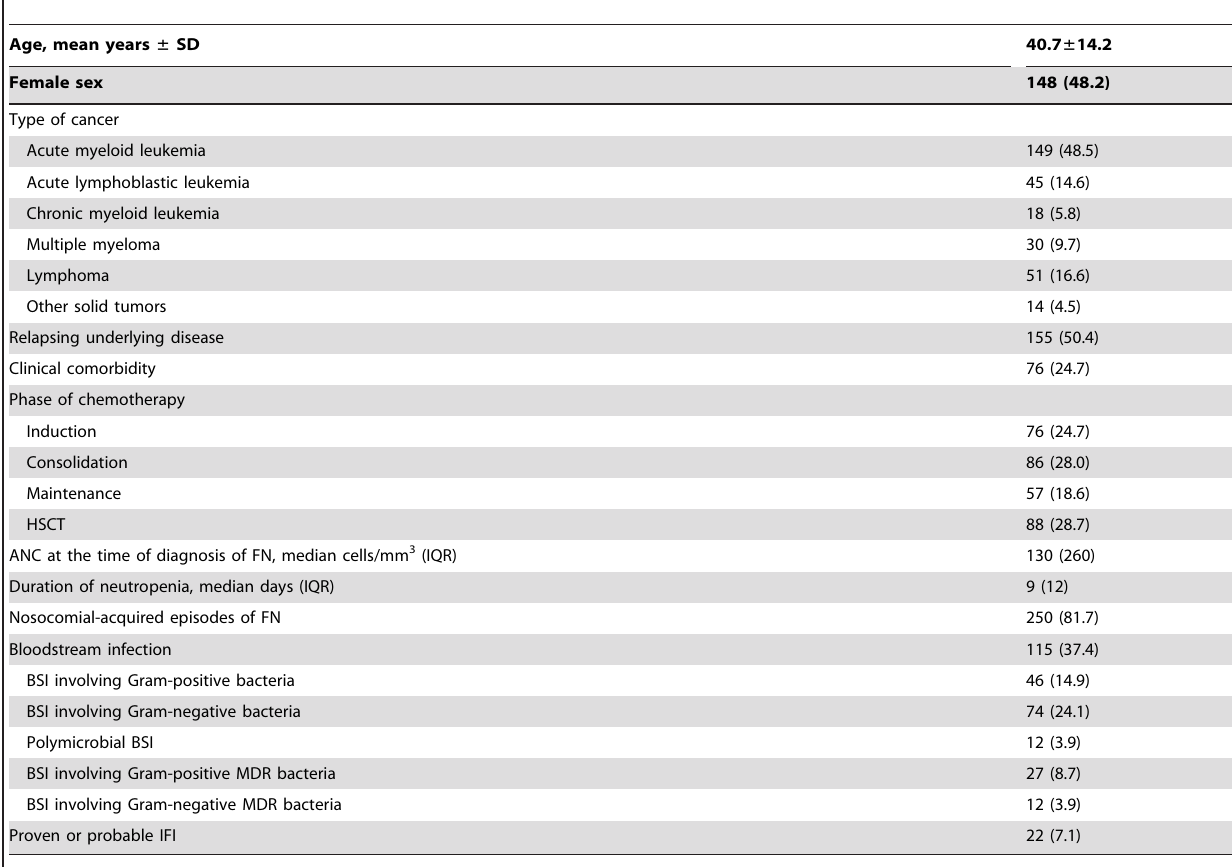
Table 1. Clinical characteristics in 307 cases of febrile